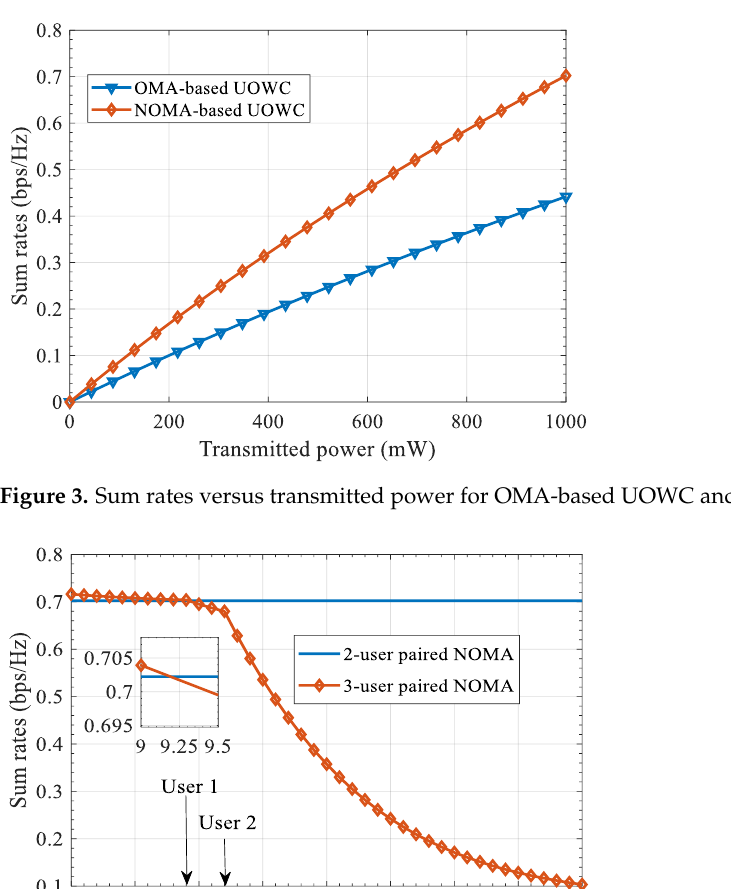
Figure 2. Diagram of simulation scenarios.